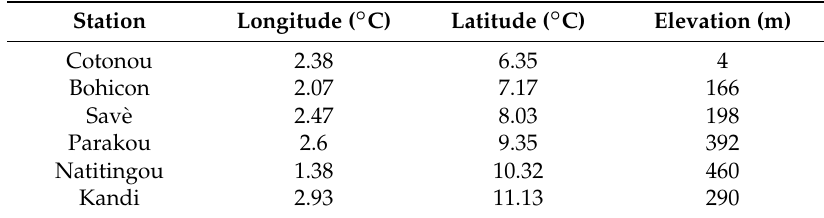
Table 1. Geographical descriptions of meteorological stations in the study area.